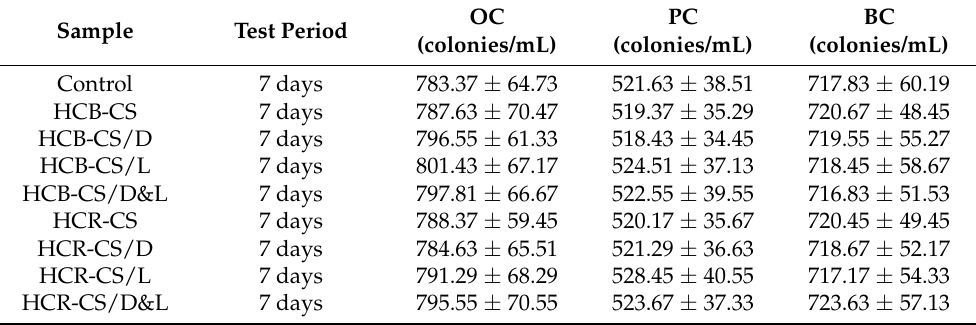
Table 9. Changes in OC, PC, and BC values in animals that received electrospun samples. Values are expressed as arithmetic mean ± SD of the average values of OC, PC, and BC, for 5 mice per